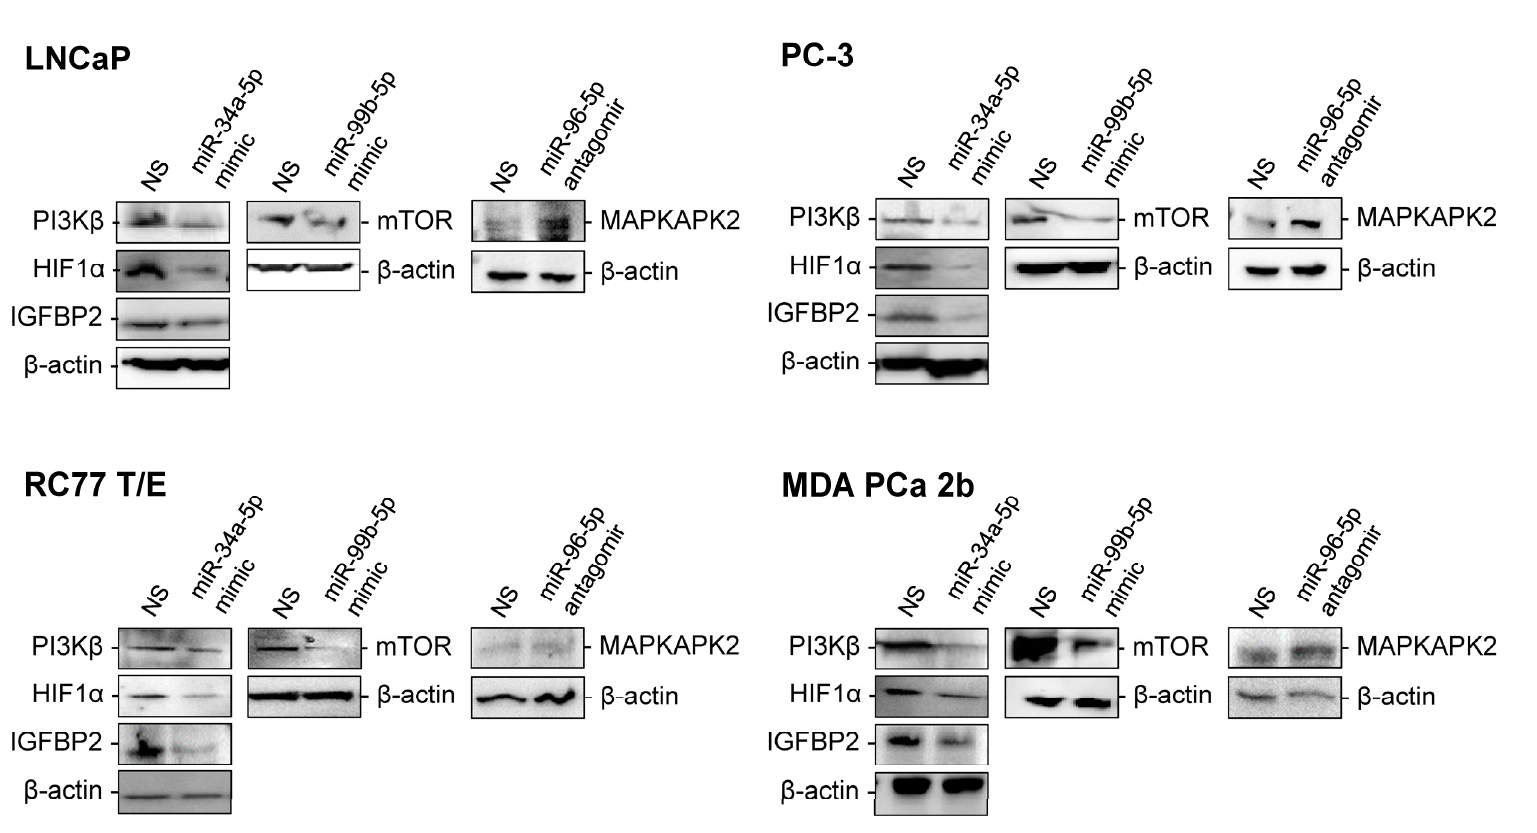
Figure 4. Western blot analysis of mTOR, PI3K β , HIF1 α , IGFBP2 and MAPKAPK2 in EA and AA PCa cell line models transfected with miRNA mimics or antagomir. Protein levels of mTOR, PI3K β , HIF1 α , IGFBP2, MAPKAPK2 and β -actin were shown in EA PCa (LNCaP and PC-3) and AA PCa (RC77 T/E and MDA PCa 2b) cell lines transfected with nonsense scrambled miRNA (NS), miR-34a-5p mimic, miR-99b-5p mimic, or miR-96-5p antagomir. Representative Western blot images were selected from 3–4 independent immunoblot assays with consistent results.